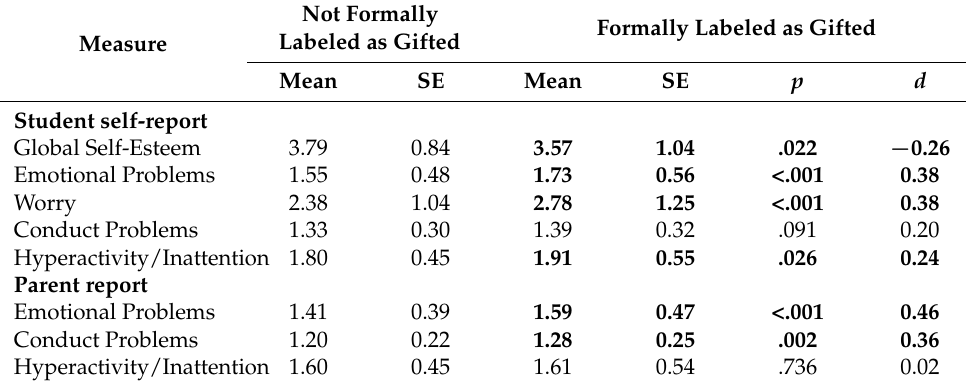
Table 4. Comparison of mental health indicators between non-labeled adolescents and adolescents formally labeled as